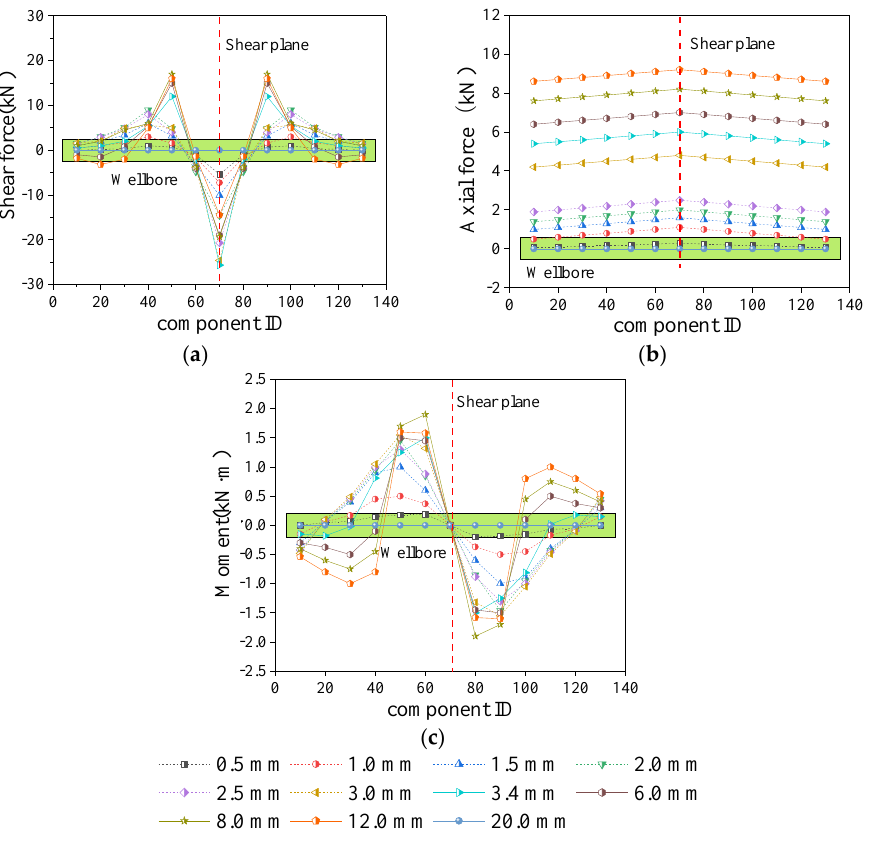
Figure 12. Distribution and evolution of the shear force, axial force and bending moment of the wellbore: ( a ) shear force of the wellbore; ( b ) axial force of the wellbore; ( c ) bending moment of the wellbore.